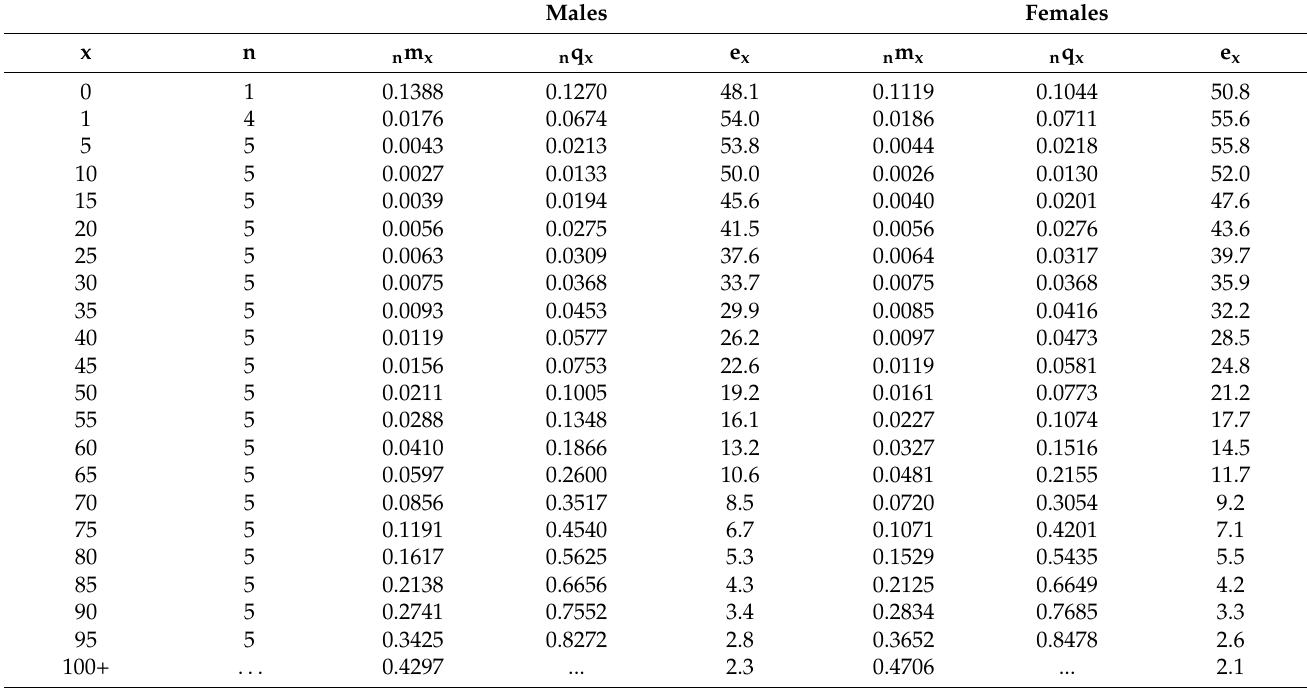
Table A11. Central Greece and Euboea